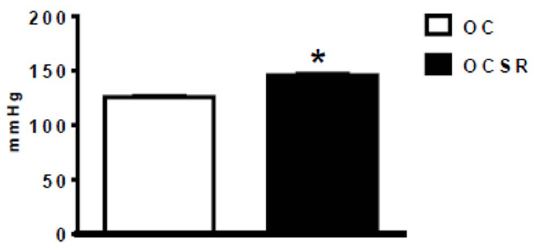
Figure 2. Systolic blood pressure – indirect measurements. OC [the offspring from the control mothers, 127 6 2.6 (19)]; OCSR [the offspring from the chronically sleep restricted mothers, 144 6 2.6 (17)] * p # 0.05 vs. the OC group (Student’s t -test).